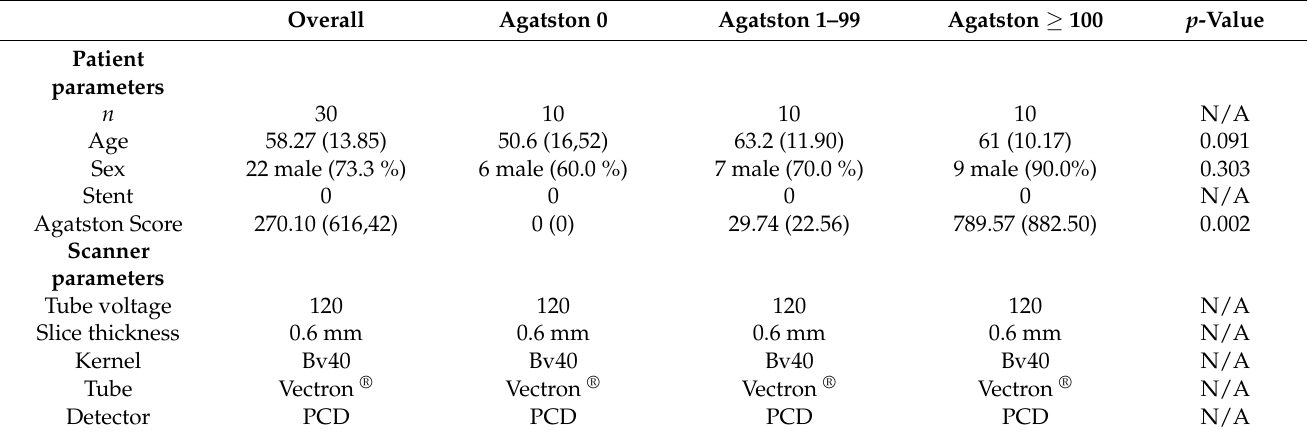
Table 1. Patient overview. Mean and (SD) given for continuous